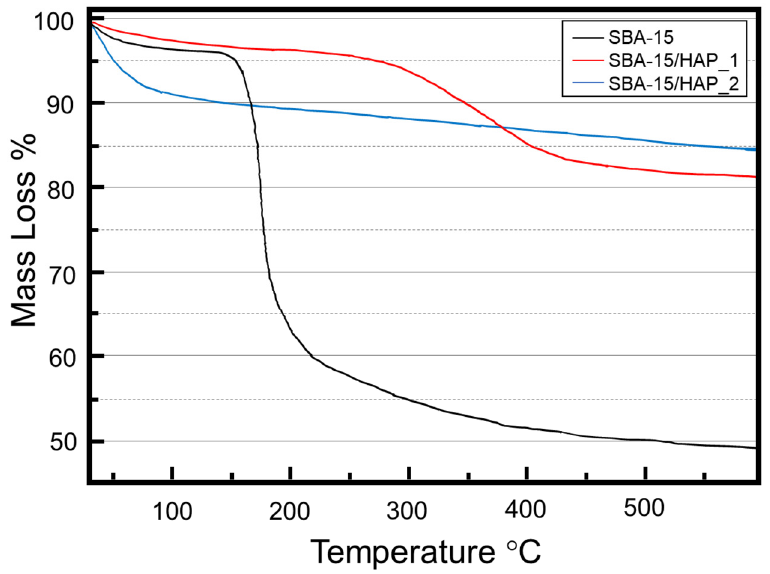
Figure 4. Thermogravimetric profile from SBA-15, SBA-15/HPA_1, and SBA-15/HBA_2 mesoporous silica showing the polymer decomposition as the generation of a mesoporous structure.